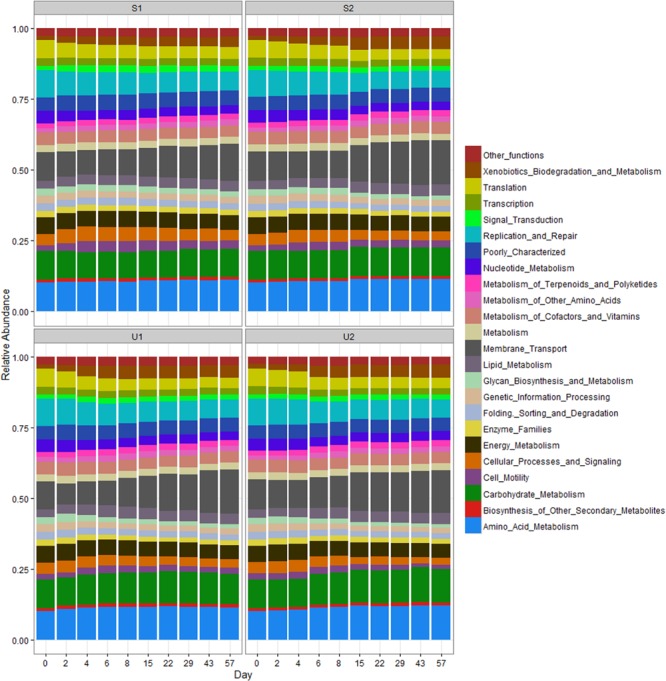
Relative abundance of PICRUSt inferred function in shaded (S) and unshaded (U) samples from farm 1 and 2. The RA is calculated by averaging the abundances of duplicate cowpats. “Other functions” includes all inferred functions with less than 1% RA.